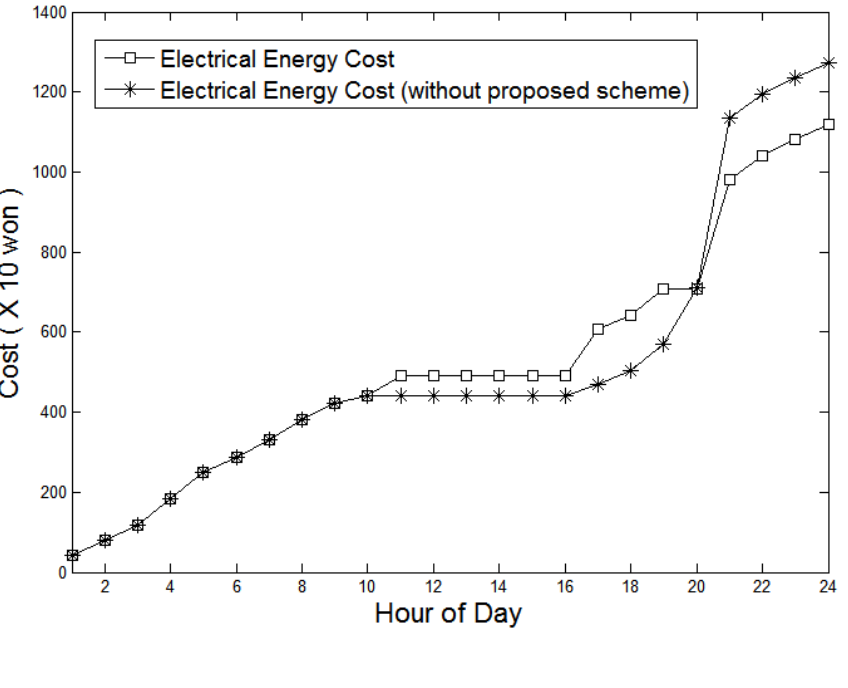
Figure 19. Comparison of electrical costs in Scenario